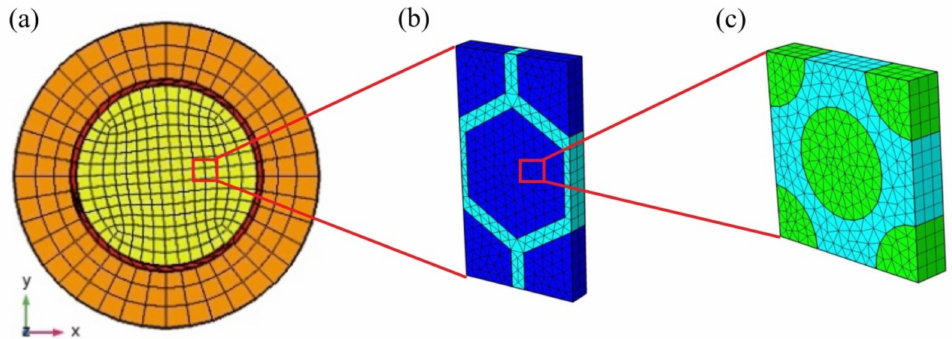
Figure 3. ( a ) Effective homogenization model of the EAS-Nb 3 Sn strand (yellow region represents the level 2 effective superconducting region, red region represents the tantalum isolation layer, and orange region represents copper); ( b ) the RVE of the level 2 (blue region represents the level 1 homogeneous fiber bundle, and cyan represents the matrix); ( c ) the RVE of the level 1 (green region represents the Nb 3 Sn fiber, and cyan region represents bronze).